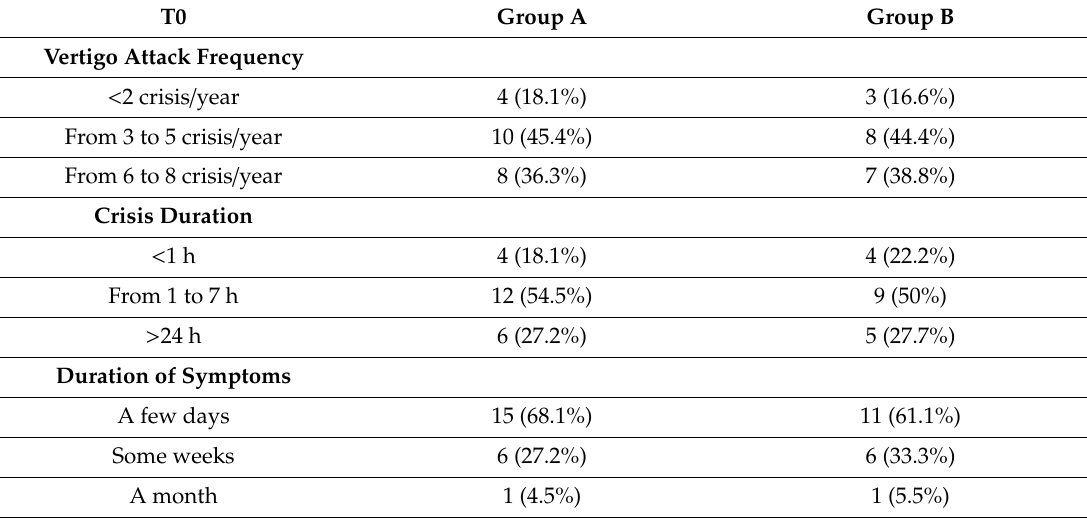
Table 2. Crisis frequency.